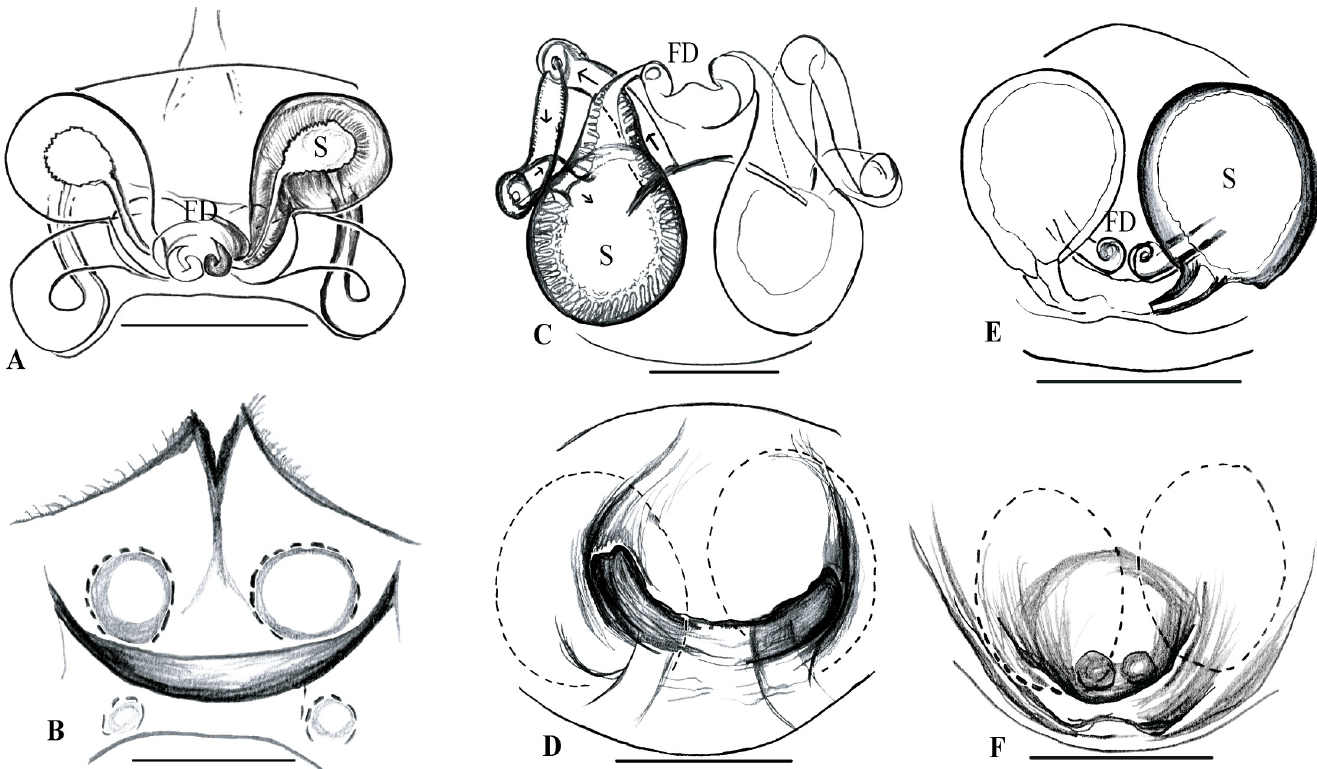
Fig 7. Female genital morphology of Rhomphaea species of Sri Lanka. A–B epigynum of R . shanthi sp. nov; A dorsal view; B ventral view. C–D epigynum of R . martini sp. nov.; C dorsal view, D ventral view. E–F epigynum of R . marani sp. nov.; E dorsal view; F ventral view. Abbreviations = S, spermathecae; FD, fertilization duct. Scale bars = 0.1 mm (A, C, F), 0.2 mm